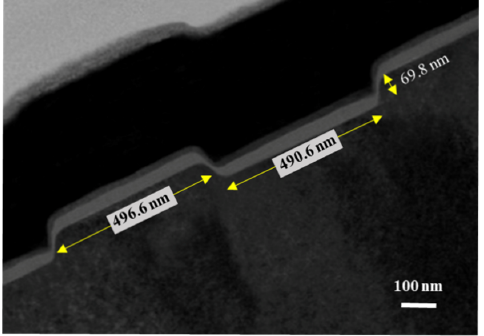
Figure 4. High resolution transmission electron microscope image of cross-sectional fin-channel.